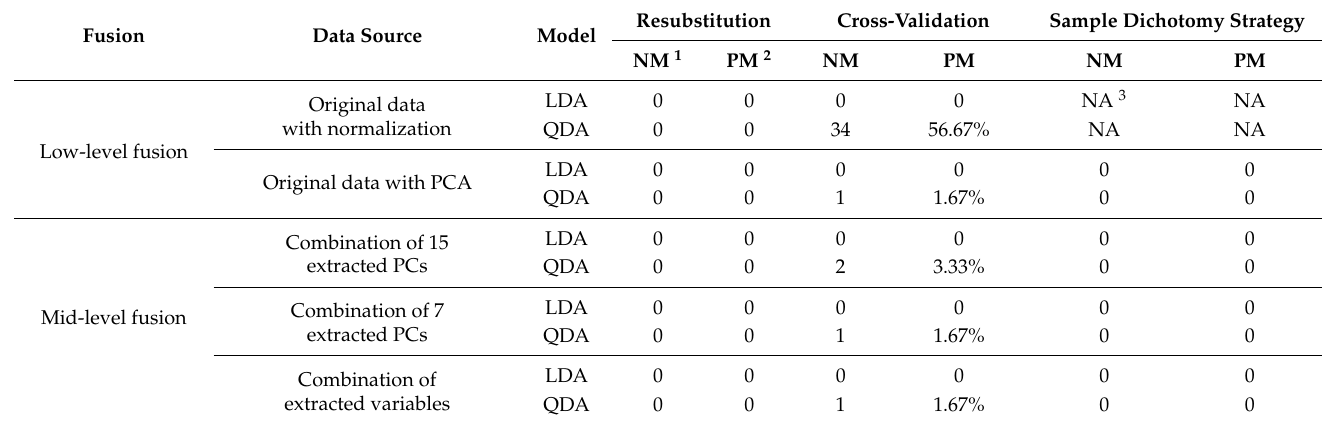
Table 3. Percentage of samples misclassified by LDA and QDA using different data fusion methods and